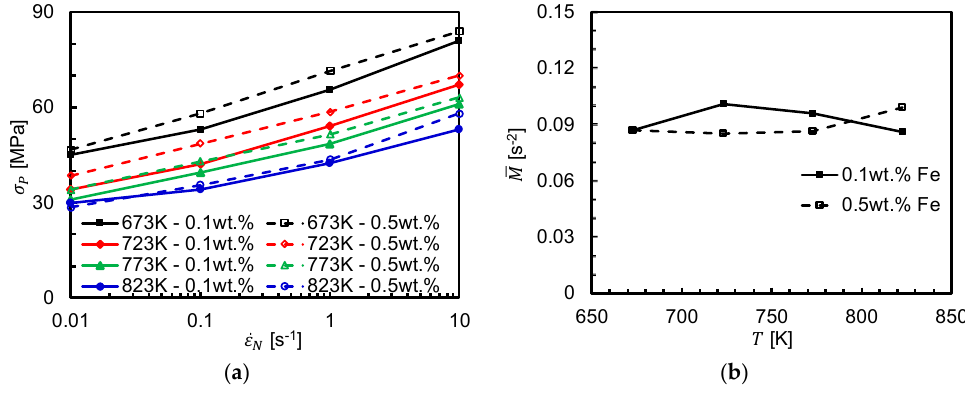
Figure 5. ( a ) Peak stress ( . ε σ ) vs. nominal strain rate ( ε ) curves and ( b ) the average strain rate sensitivity exponent ( M , Equation (2)) of both recycled Al alloys.